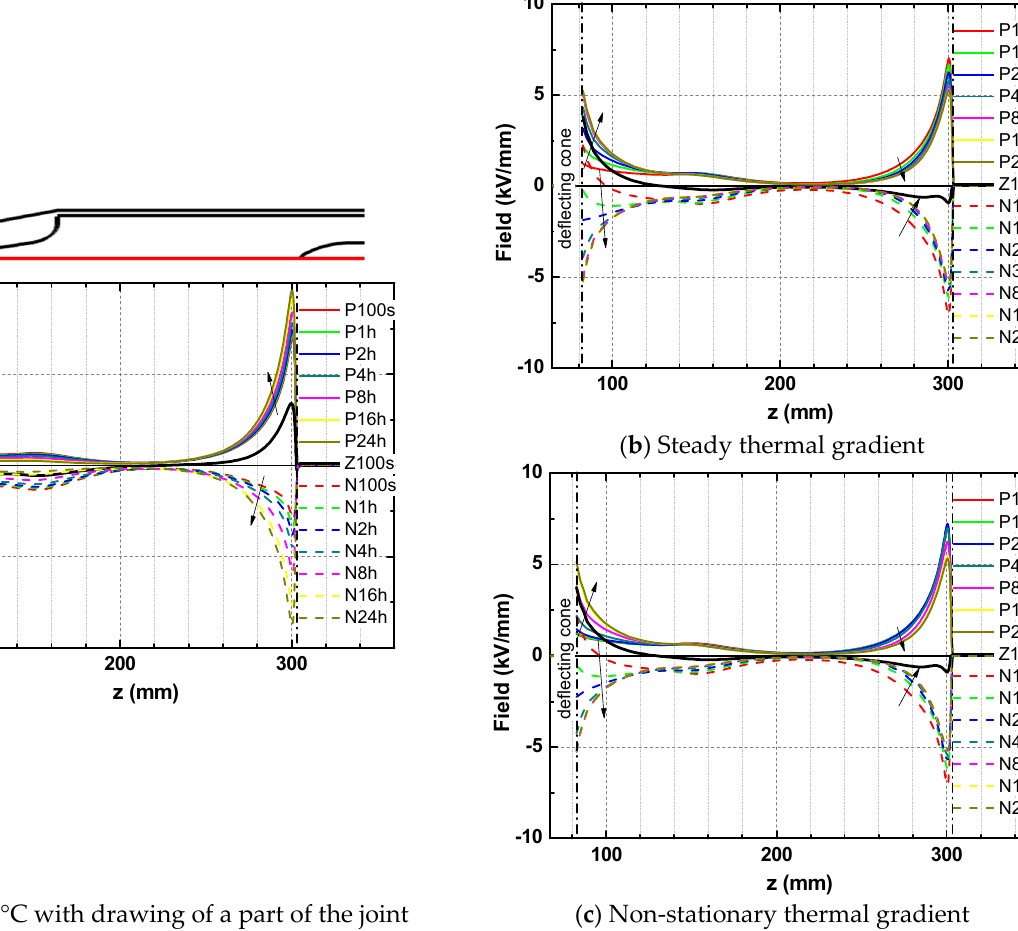
Figure 8. Tangential field distributions at the XLPE/EPDM interface at different times after voltage application. The drawing at the top of ( a ) represents a part of the joint. The axial field profiles are taken along the red line at the interface between XLPE and EPDM. Vertical lines define insulator boundaries. The curve in black corresponds to the reset to 0 after 24 h at +200 kV. Ground on the left; HV on the right. Same conventions as in Figure